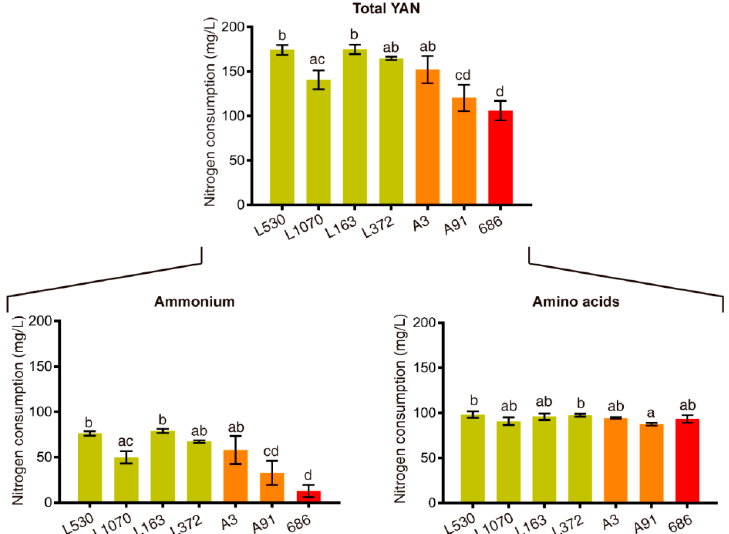
Figure 2. YAN consumption of improved strain “686” and their parental strains. Consumption of nitrogen sources are shown for improved strain “686” (red bar) and their respective F 1 “parents” (A3 and A91) (orange bars) and F 0 “grandparents” (L530, L1070, L163 and L372) (dark-yellow bars). Statistical analysis for each nitrogen source consisted in independent ANOVA followed by Tukey’s tests, with values that have a statistically significant difference ( p -value < 0.05) having different superscript letters (a and b). Plotted values correspond to three biological replicates average, with error bars representing their standard error (mean ±